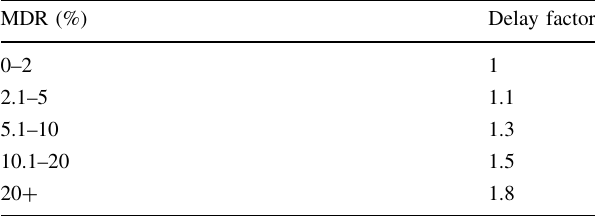
Table 3 Delay factors per overall MDR